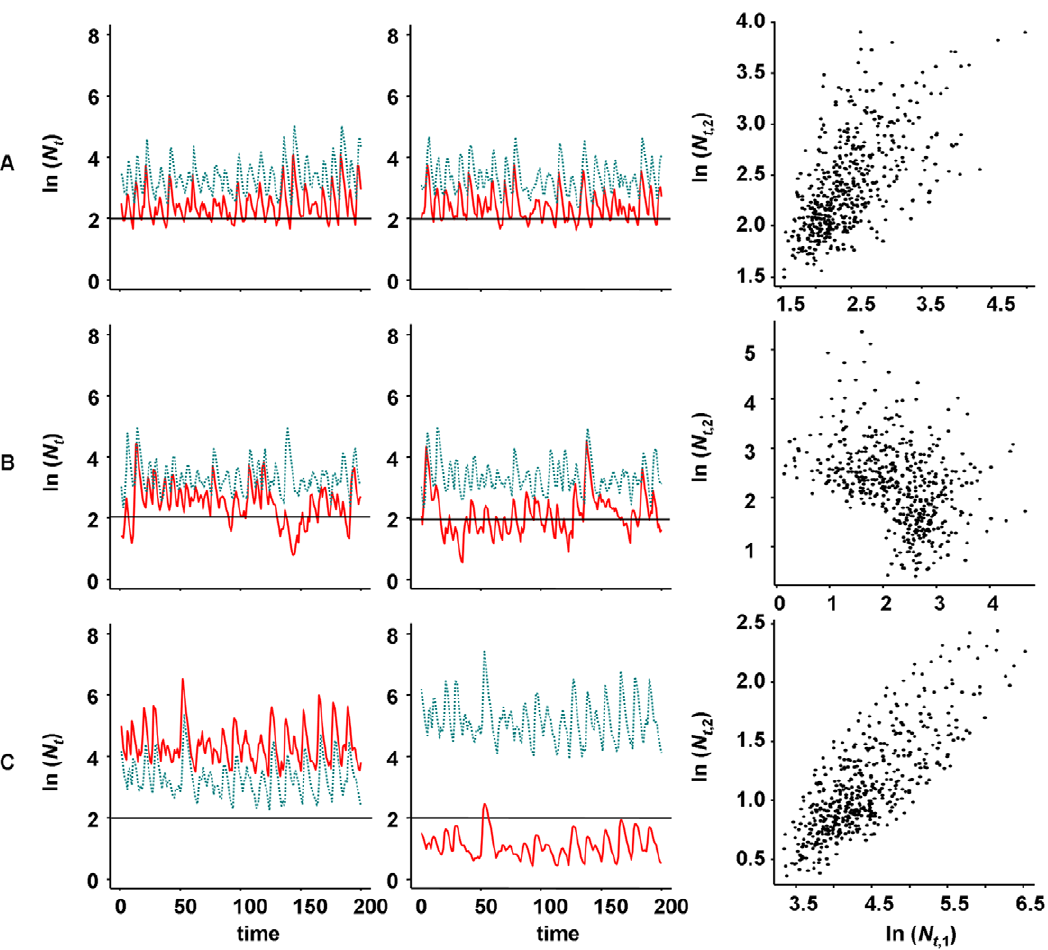
Figure 5. Representative time series of simulated host (solid, red line) and parasitoid (dotted, blue line abundances from two patch metapopulations (left and middle panels). Panels at right show host abundances in patch 1 (left panels) against patch 2 (middle panels). Row (a): 10% host dispersal; 10% parasitoid dispersal; row (b): 1% host dispersal; 50% parasitoid dispersal; and row (c): 1% host dispersal; 90% parasitoid dispersal.